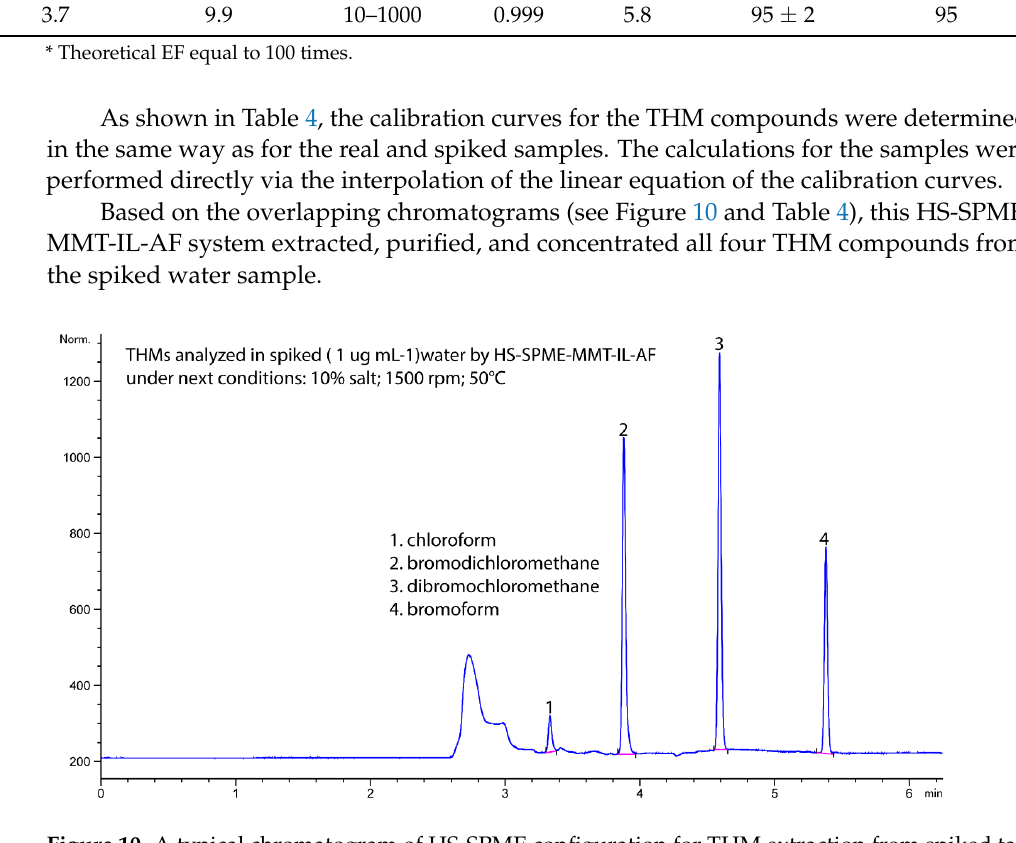
Figure 10. A typical chromatogram of HS-SPME configuration for THM extraction from spiked tap water with HS-SPME-MMT-IL on an agarose film.